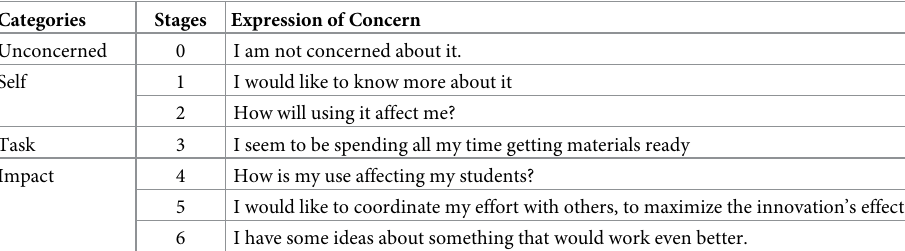
Table 1. Typical expressions of concern about an